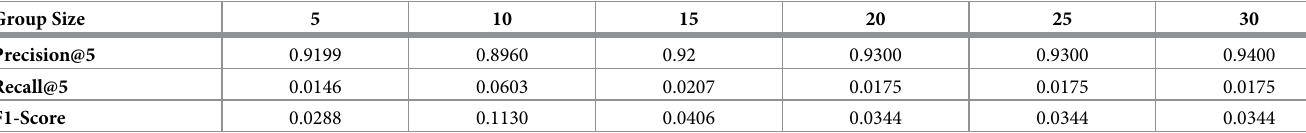
Table 16. Performance of ALS by varying group size.